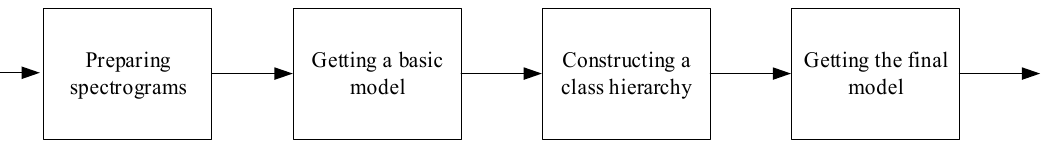
Figure 2. Flowchart of the proposed